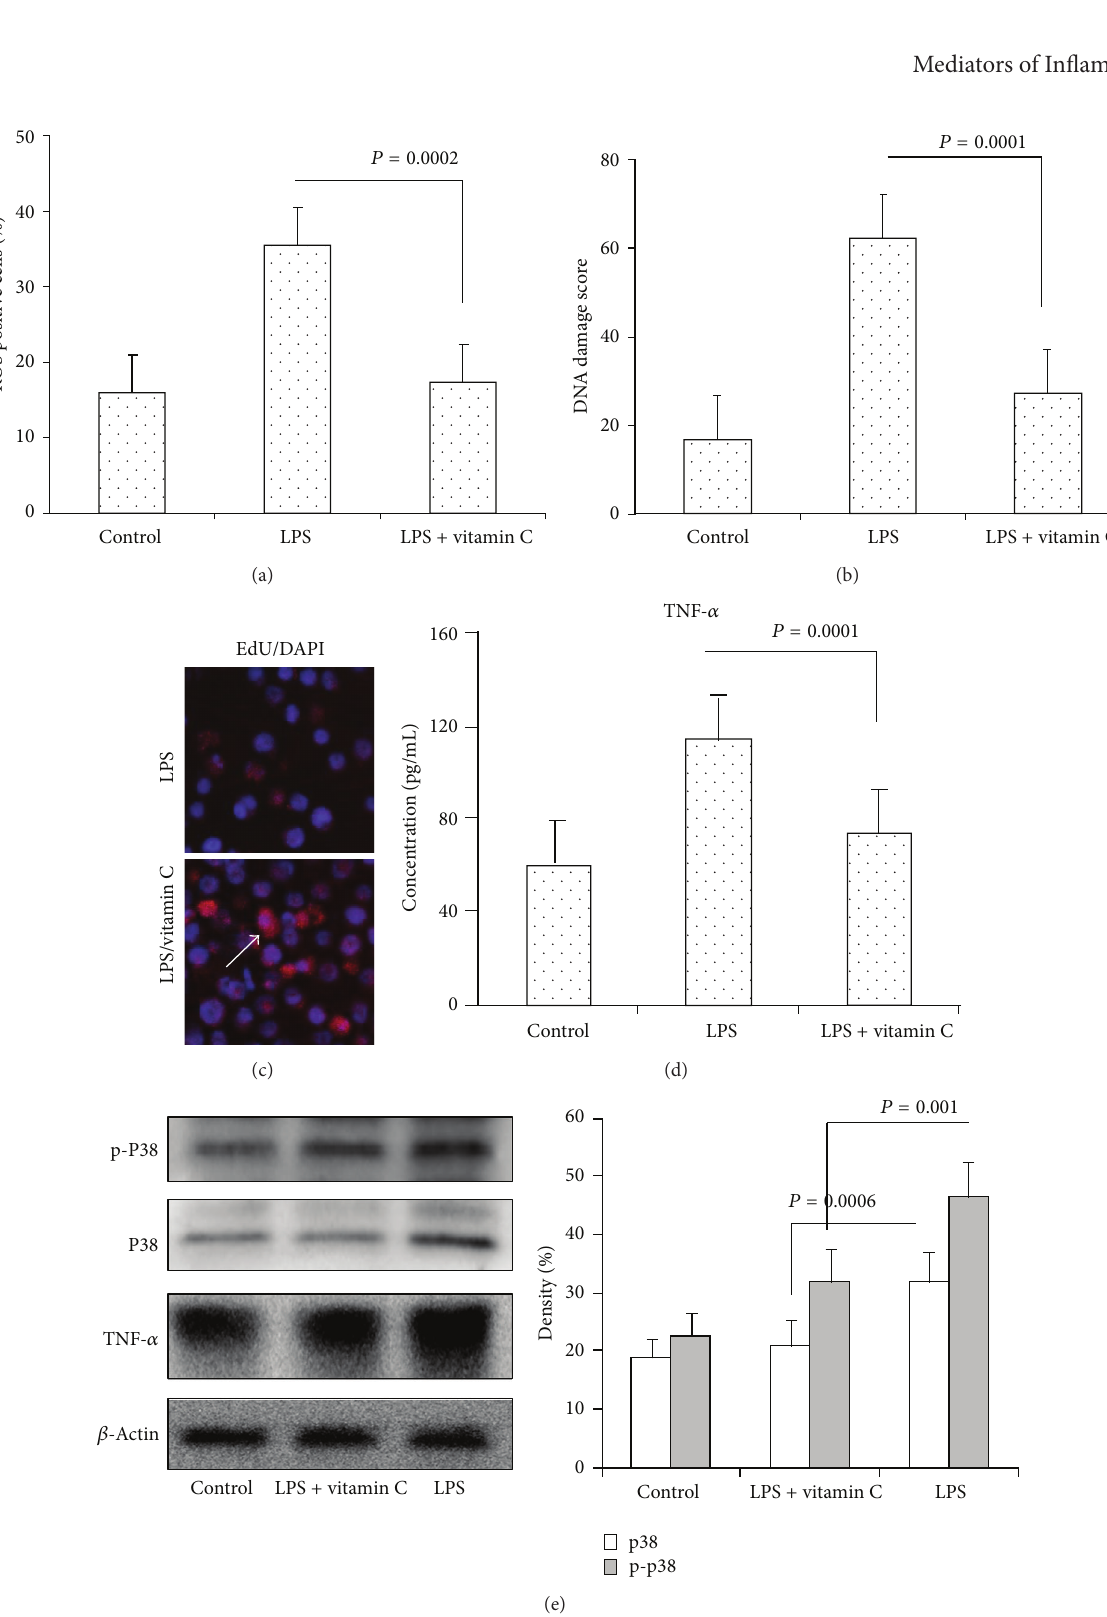
Figure 4: The effect of vitamin C on oxidative stress and DNA damage in LPS-induced MH-S cells . ROS and DNA damage in MH-S cells were measured in the presence or absence of vitamin C and treated with LPS for 12 hours. (a) ROS were detected by confocal microscope using DCFH-DA probe. ROS level was represented by fluorescence intensity. (b) DNA damage was measured by comet assay. DNA damage score was analyzed with comet assay IV software. (c) MH-S cells viability was detected by confocal microscope using Edu staining ( × 200). Arrow showed viability of cells. (d) TNF- 𝛼 was measured by ELISA. (e) TNF- 𝛼 , P38, and p-P38 were determined by western blotting. 𝛽 -actin was used as the loading